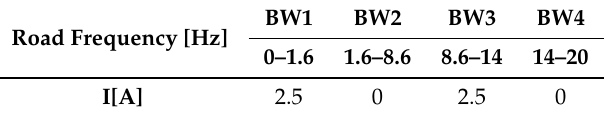
Figure 8. Force-electric current conversion with PI controller. Table 7. Frequency Estimation Based (FEB) Frequency bandwidths for the QoV .